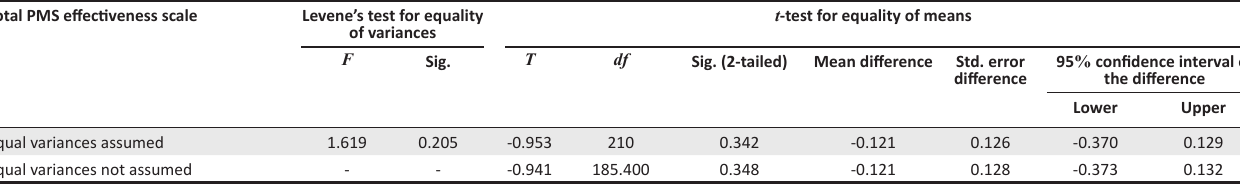
TABLE 6: Independent samples t -test of the differences in the mean perception scores of the performance management system effectiveness between men and women. Total PMS effectiveness scale